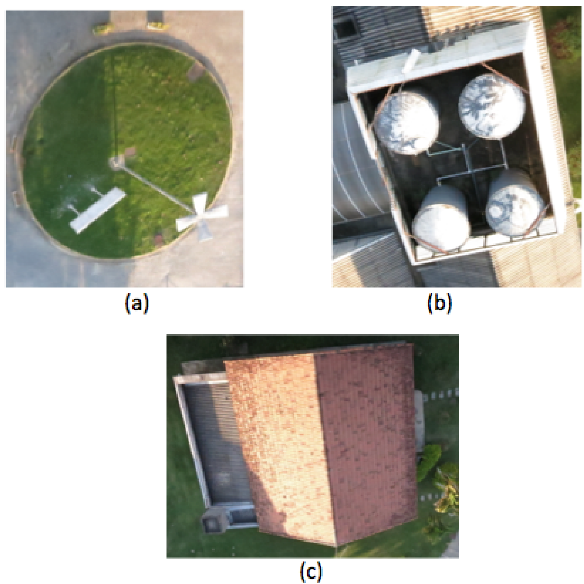
Figure 4. Landmarks chosen from the pattern image flight